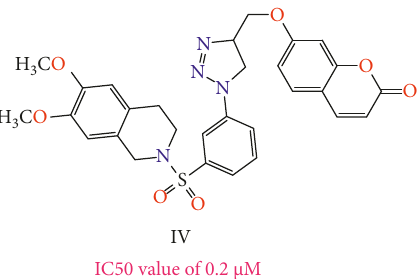
Figure 9: Aromatase inhibition activity of 1,4-disubstituted-1,2,3-triazole sulfonamide